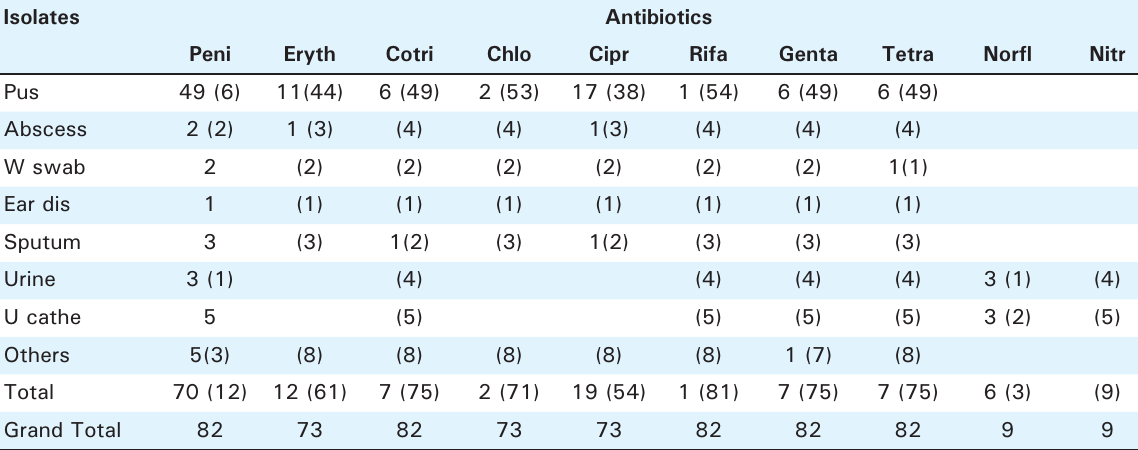
Table 3. Susceptibility pattern of